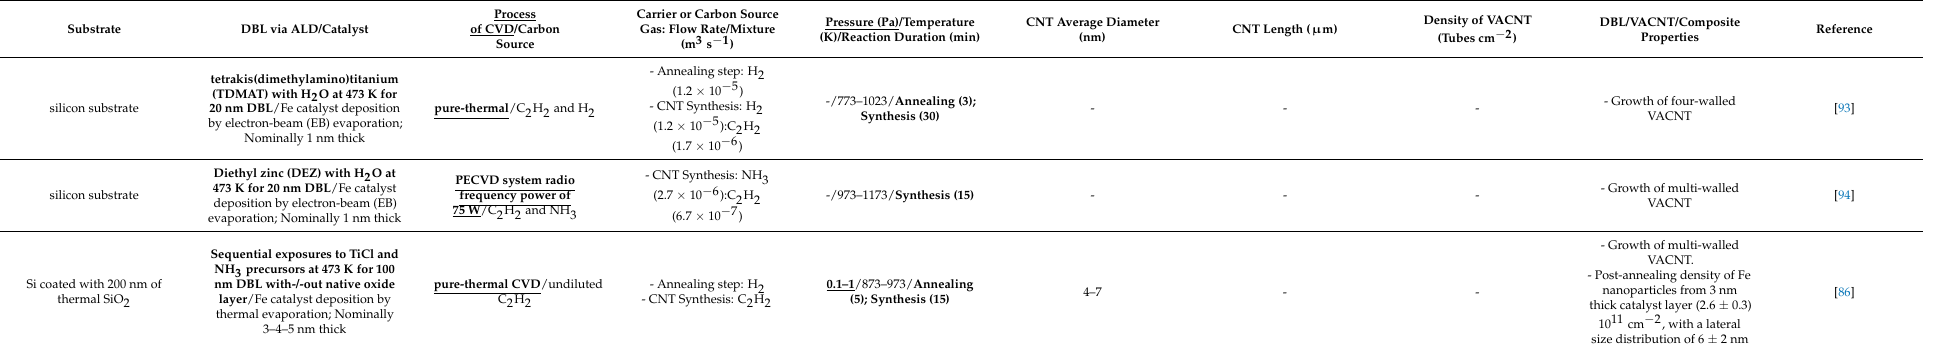
Table 6. Details of used substrate, DBL (deposited via ALD), and VACNT growth conditions and